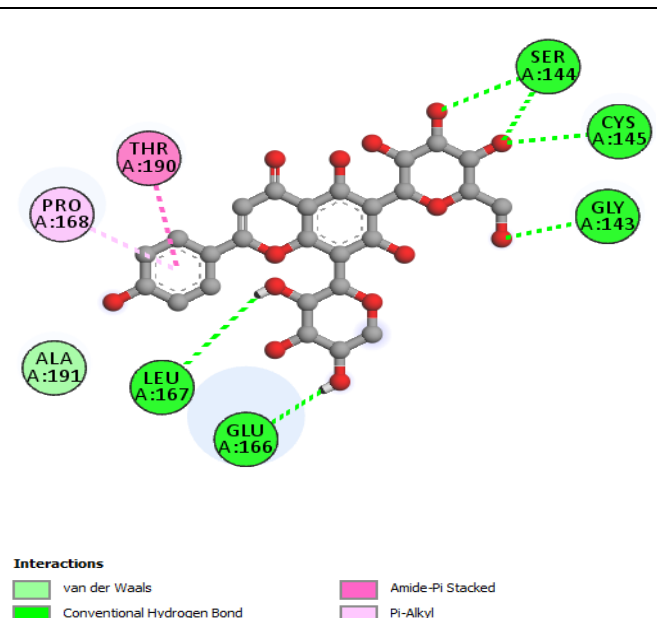
Figure 3. 2D interactions of rutin with Mpro.